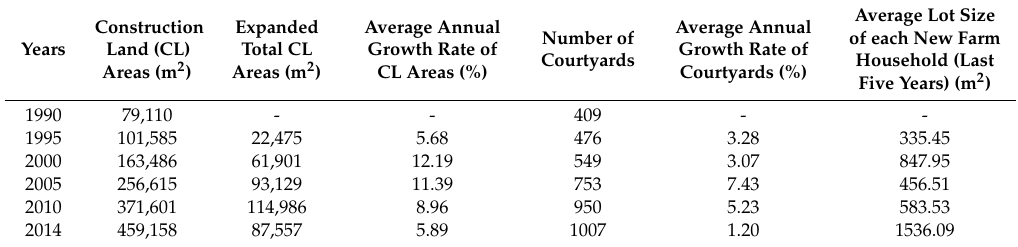
Table 1. Construction land (CL) and courtyard changes in Fengzhuang from 1990 to 2014.